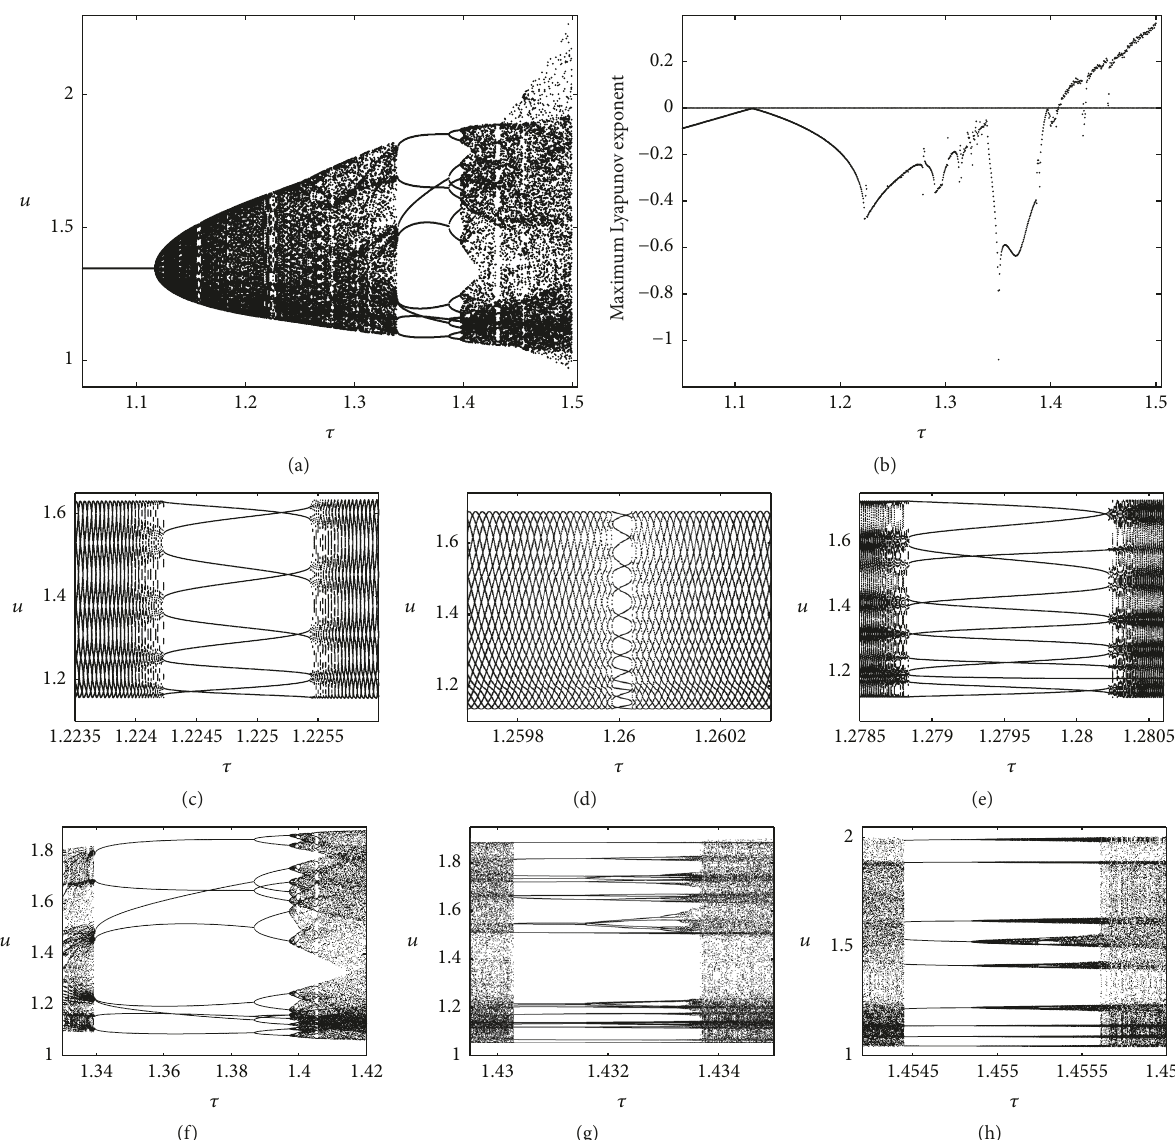
Figure 3: (a) Neimark-Sacker bifurcation diagram with 𝜏 covering [1.05, 1.505] ; (b) maximum Lyapunov exponent corresponding to (a); (c)–(h) local amplifications of (a). 𝑎 = 2 , 𝑏 = 2 , 𝑐 = 2 , 𝑑 = 1.75 , 𝛼 = 0.1 , and 𝛽 = 0.1